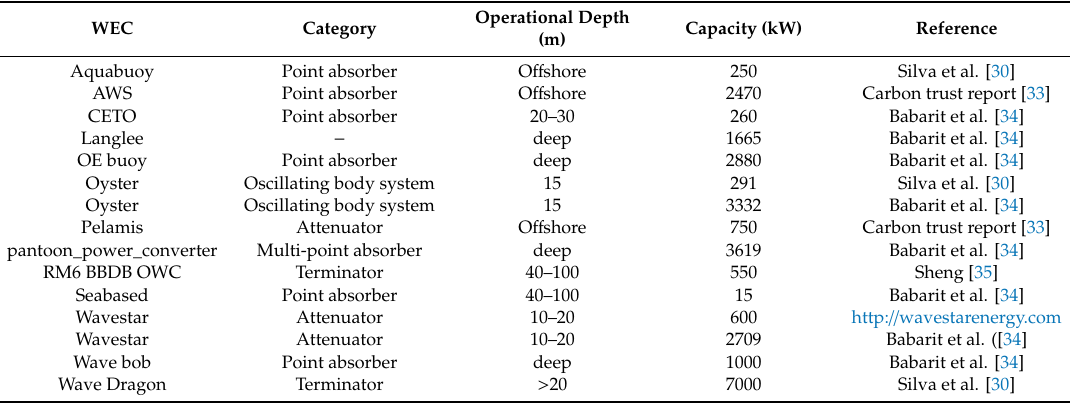
Table 4. Details of the wave energy convertors used in the